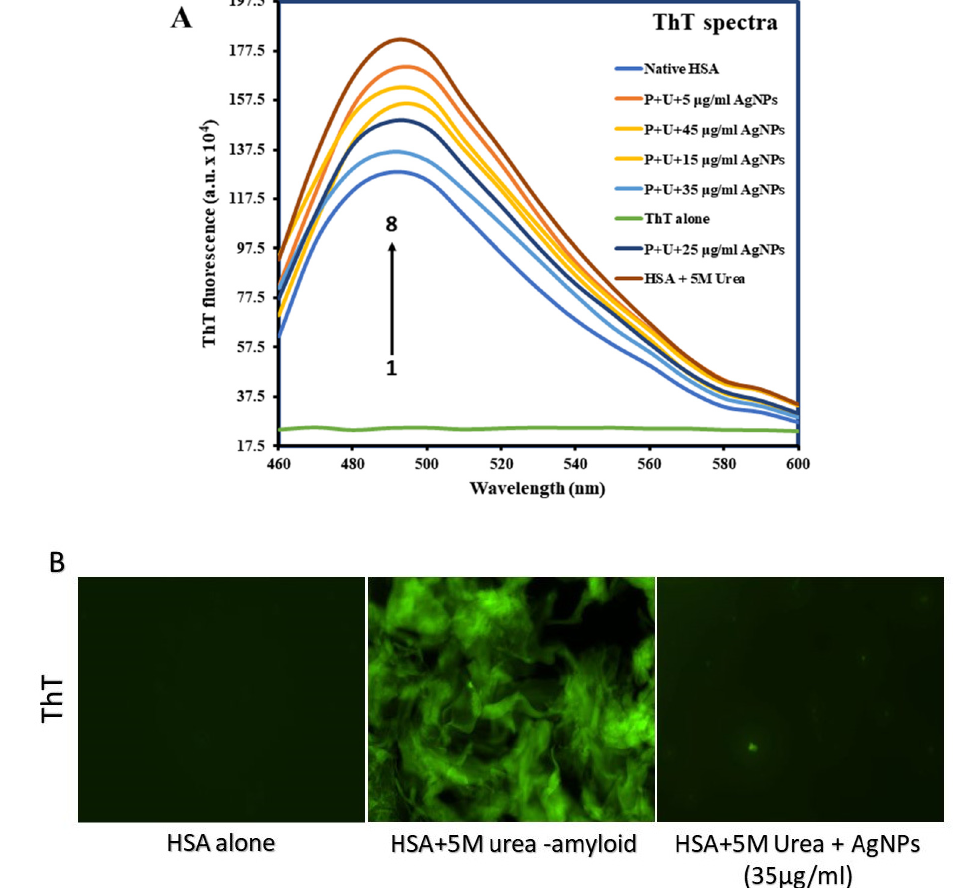
Figure 4. ( A ) ThT fluorescence spectra of native HSA (curve 2), HSA in the presence of 5 M urea (curve 8) and HSA in the presence of increasing concentrations of B-AgNPs (curves 3–7). HSA was used at a final concentration of 5 µM, while ThT was used at a final concentration of 20 µM. ( B ) Green color fluorescence indicates HSA amyloidal aggregates coupled to ThT. Fluorescence microscopy is used to visualize HSA amyloidal aggregates. Micrographs of HSA aggregates as generated in the presence or absence of B-AgNPs at 10X magnification at 100 µm scale.